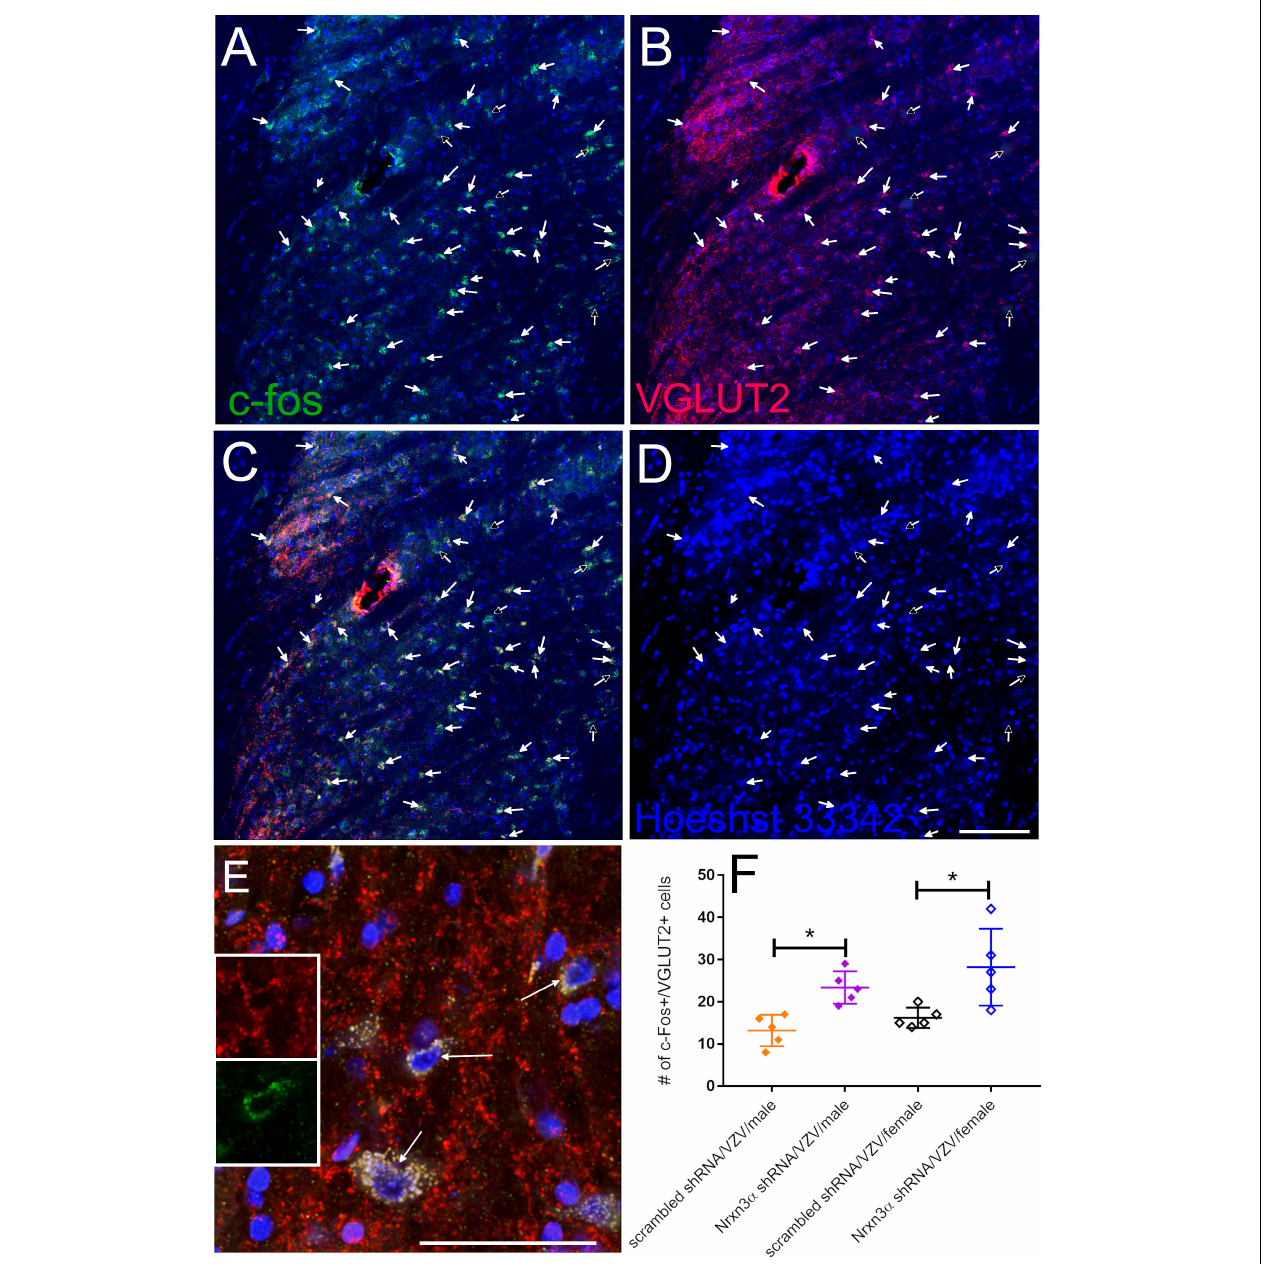
FIGURE 4 | Excitable neurons had increased activity in the parabrachial after infusion of the central amygdala with Nrxn3 α shRNA. Images are from the lateral parabrachial region of a female rat after infusion of the central amygdala with scrambled shRNA or Nrxn3 α shRNA and after having injected the vibrissa pad with VZV. In (A) , the c-fos staining is shown in green and in (B) the VGLUT2 staining is shown in red. Cells that have c-fos and VGLUT2 colocalized are shown in yellow in (C) . Hoechst 33342 nuclear stain is blue in (D) . The arrows point to cells that were counted as c-fos and VGLUT2 positive. Open arrows points to cells that were considered c-fos positive but did not show a VGLUT2 signal. Bar = 100 µ m. (E) Shows a high magnification of cells that have c-fos and VGLUT2 colocalized (yellow, arrows). Inserts show higher magnification image of the cell in the center, VGLUT2 (upper insert) and c-fos (lower insert). Bar = 50 µ m. (F) Is a histogram of the counts from the different treatment groups for cells that had the c-fos and VGLUT2 fluorescent signal co-localized. Each point on the histogram represents an individual animal and the asterisk indicates p <